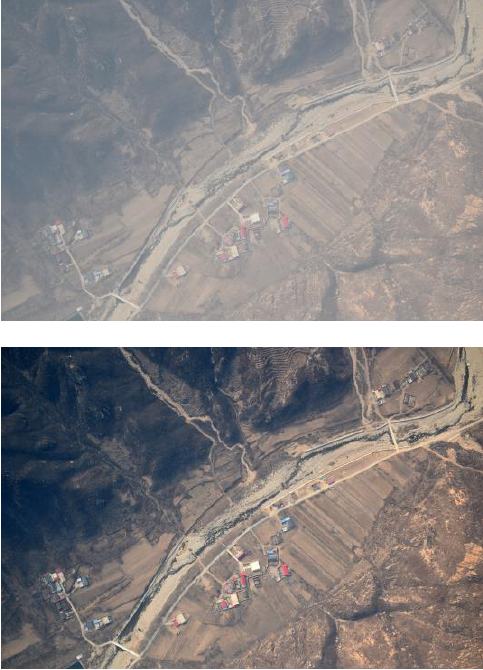
Figure 1. The original aerial image and the enhanced image The resolution of the images is 7360 by 4912. The number of the extracted SIFT feature points from the enhanced images is 0.2% less than that from the original ones on average.